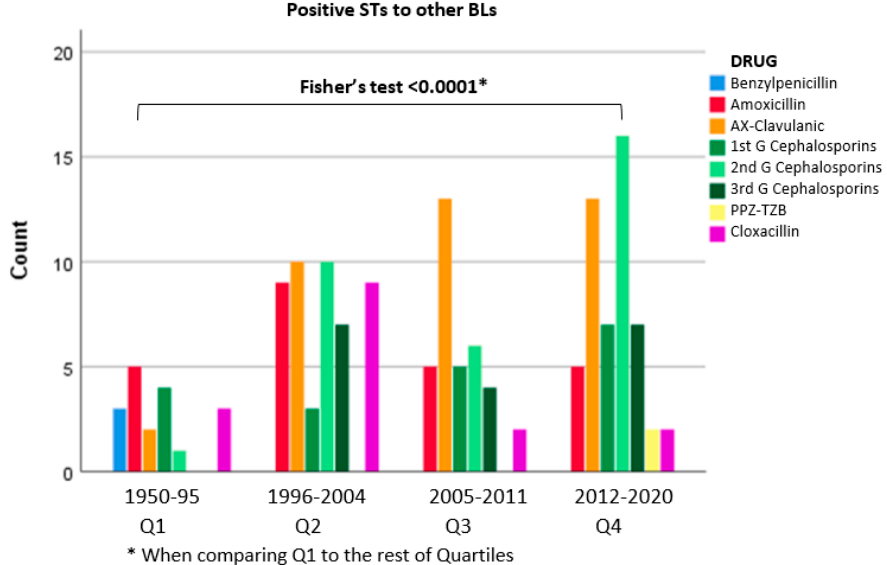
Figure 3. Positive STs to other BLs related to the eliciting BL. Focusing on AX and AX-CLV, representing 39.6% and 30.4% of total patients, 240 patients had positive STs exclusively to AX (38.7% of total patients). Analyzing the differences by quartiles, in line with the increased frequency of AX as a triggering drug over the years, we found that 34 patients in Q1 (23.6%) had selective positive STs to AX. This percentage increased from Q2 onward, reaching 43.6%, 42.4%, and 43.6% in Q2, Q3, and Q4. Concerning CLV, 30 patients had positive STs exclusively with CLV, being negative with AX and BP reagents; thus, CLV was the drug involved in 16% of patients who